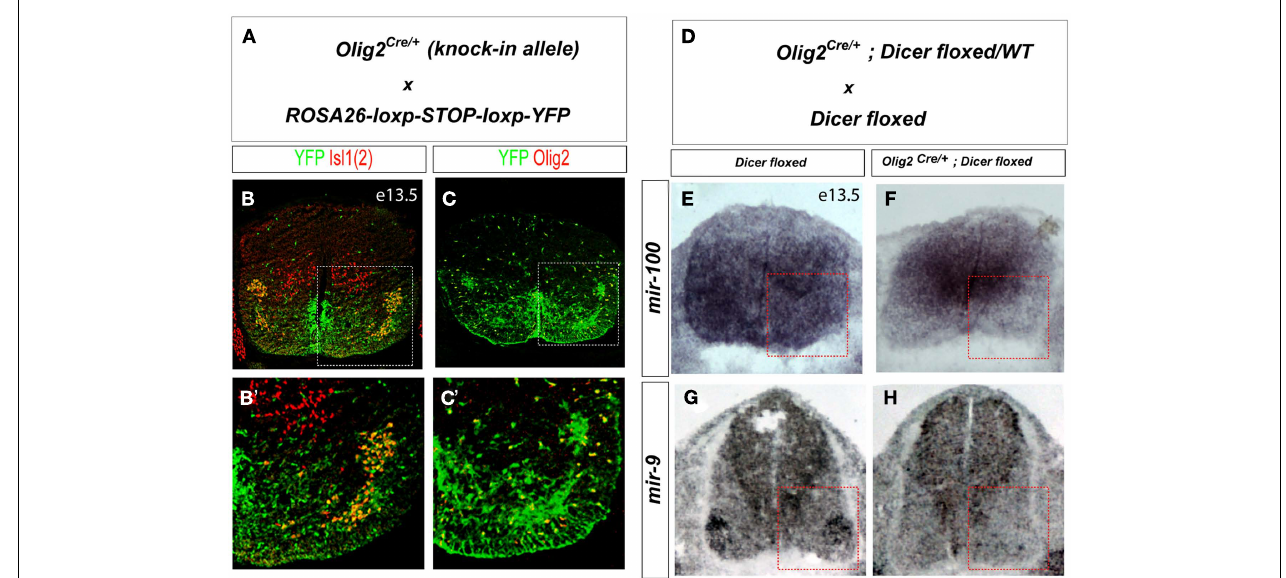
FIGURE 1 | Efficient and specific disruption miRNA biosynthesis in Olig2 Cre/ + ; Dicer flox/flox animals. (A) Schematic illustration of Olig2-Crelineage tracing (YFP on cells) in Olig2 Cre/ + ; ROSA26-loxp-STOP-loxp-YFP E13.5 spinal cord sections. (B,C) Cre mediated recombination in Olig2 expressing progenitors results inYFP expression in all cells derived from this progenitor domain.YFP is expressed in all postmitotic motor neurons in the ventral horn of the spinal cord (YFP on and Isl1 on ), but not in dorsal dl3 interneurons